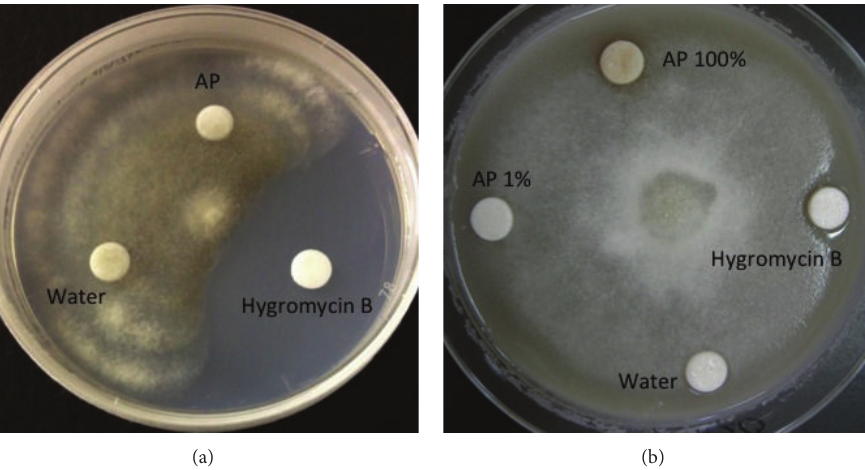
Figure 4: Algal extract showed no antifungal activity against P. infestans or B. cinerea . (a) Disks infiltrated with 20 𝜇 L of AP (100%), AP (1%), and Hygromycin B (150 𝜇 g/mL) as a positive control or H 2 O as a negative control. Photograph was taken 5 days after inoculation. (b) Disks infiltrated with 20 𝜇 L of AP (100%), Hygromycin B (150 𝜇 g/mL) as a positive control or H 2 O as a negative control. Photograph was taken 7 days after inoculation. Experiment were repeated three times and showed similar